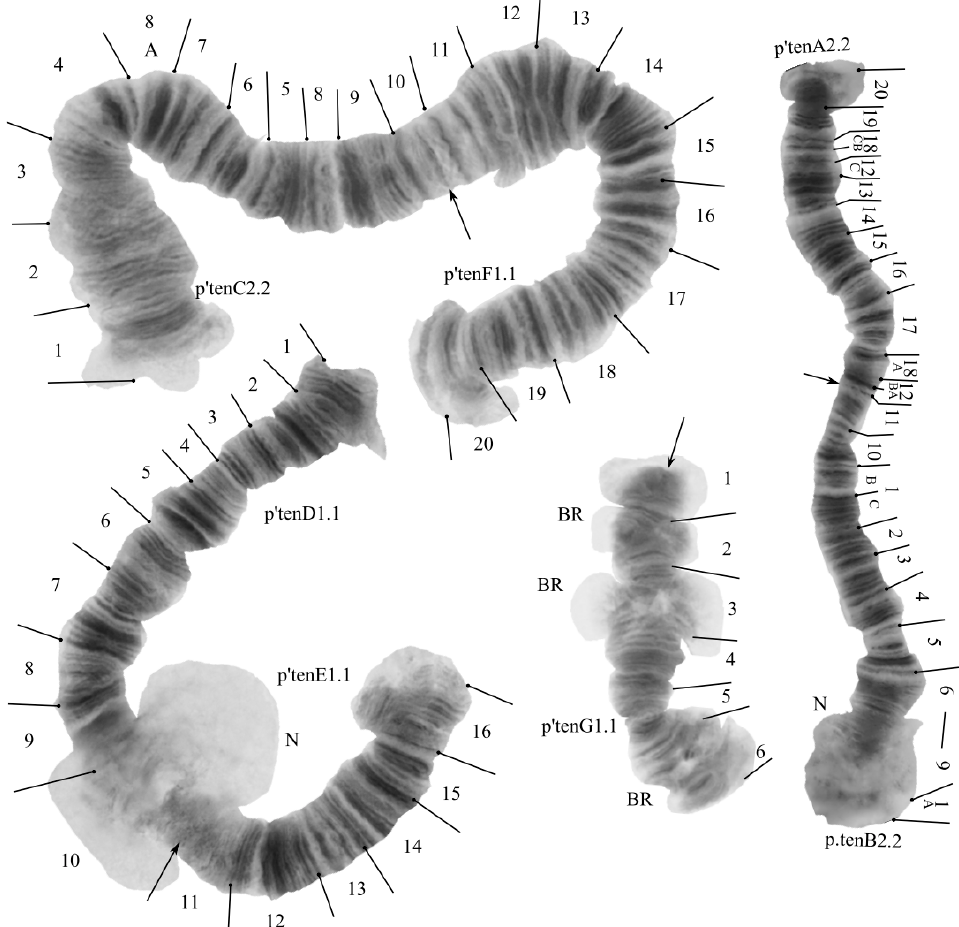
Arm G—one banding sequence: p’balG1. Not mapped.